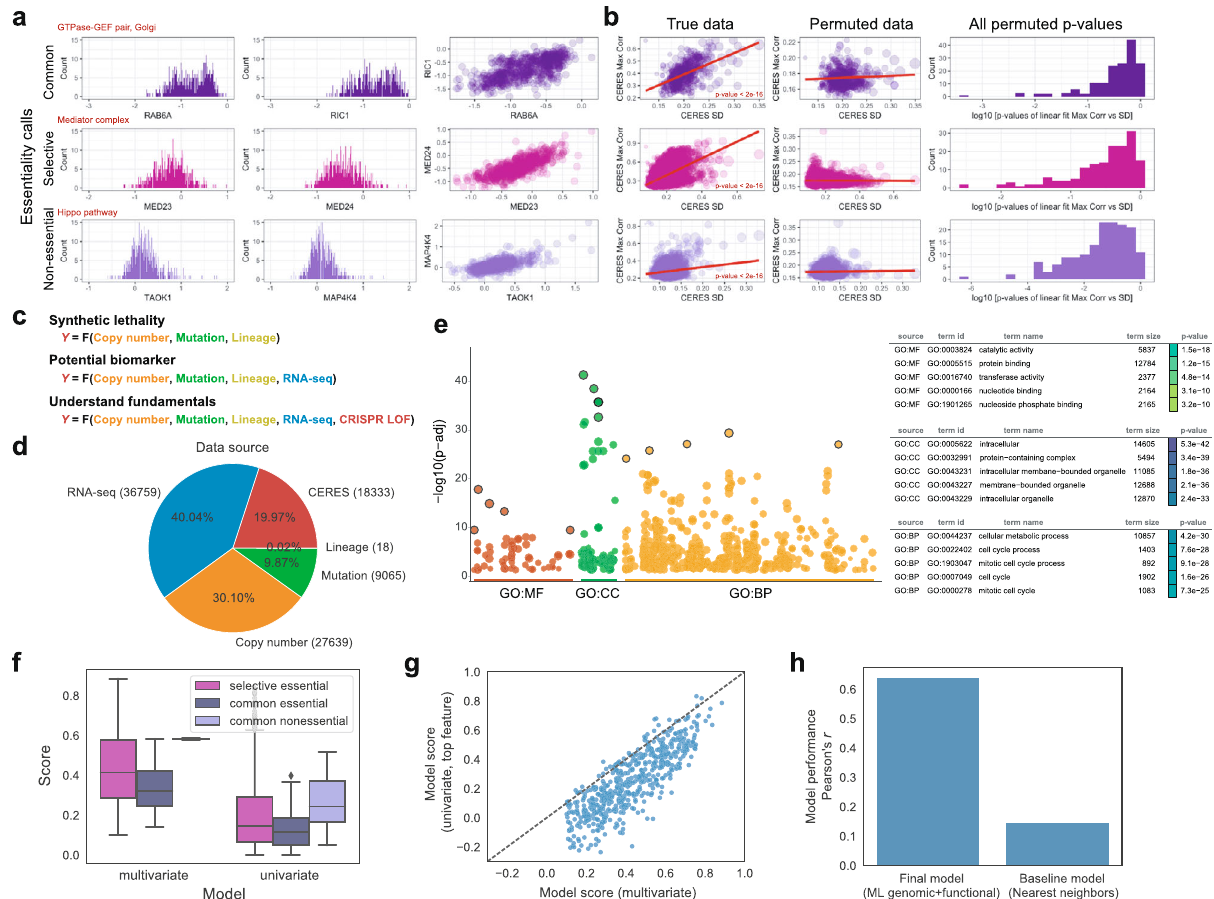
Fig. 1 Multivariate machine-learning models predict context speci fi city. a Examining the largest and most cell-type-speci fi c genes in the DepMap dataset identi fi ed genes for whom CERES scores were highly correlated with a biologically related gene in the same pathway or complex. This was true in common, selective, and nonessential DepMap genes. This suggested that continuous variation in CERES scores can have biological meaning. b Scatter plots (left, middle) have 18,333 unique genes as data points. On x axis, the standard deviation of CERES score for each gene; on y axis, the maximum correlation from all pairwise Pearson correlations for each gene to all other genes. The point size is proportional to the range of CERES scores across all cell lines. The most cell-type-speci fi c genes tend to have the strongest correlations with CERES scores in other genes. This is measured via a linear model (red line), and the P value of this model coef fi cient (based on two-sided t test) is <2e-16 in the true data (left) for common, selective, and nonessential genes. To assess the signi fi cance of the relationship between standard deviation within a gene and biological correlations with the CERES scores of another gene, one example of a permuted CERES dataset and its linear model is shown in the middle. In total, 163 permutations of the CERES scores and the P values from their respective linear models are shown in the histogram to the far right. Permuted P values rarely drop below 0.001 and are never below 10 − 6 while the real data had a P value of <2e-16. The more context-speci fi c a gene is, the more likely it is to be highly correlated to a second gene. Correlation with a second gene is an indicator that CERES score variation has biological meaning. c Different variables can be used to predict cell type speci fi c genes. d The distribution of the number of features per data source. e gpro fi ler2 plots reveal the landscape of enriched biological processes in highly context-speci fi c genes. The P values are based on hypergeometric tests with multiple testing corrections using the g:SCS method. f Comparisons in model scores (R2s) between the multivariate versus univariate models across different essentiality classes ( n = 3648, 164, 22 for selective essential, common essential, common nonessential, respectively). Boxplots are broken down by gene classi fi cation, score is based on performance during cross-validation. Box shows the quartiles, whiskers indicate the maximum/minimum non-outlier observations, dots indicate outliers falling outside of 1.5 times interquartile range, and center is the median. g After cross-validation and validation of test set predictive power, models for each context-speci fi c gene are plotted as individual points. 1 data point is 1 gene. Multivariate models ( x axis) are more predictive than univariate models ( y axis), across all gene essentiality classes. h Bar plot of Pearson correlations between model predictions and actual CERES scores, compared between the fi nal modeling approach and a baseline model that simply predicts CERES score values by retrieving the CERES score from the closest cell line (by genomic pro fi le similarities that are measured with Cellector). Source data are provided as a Source Data fi